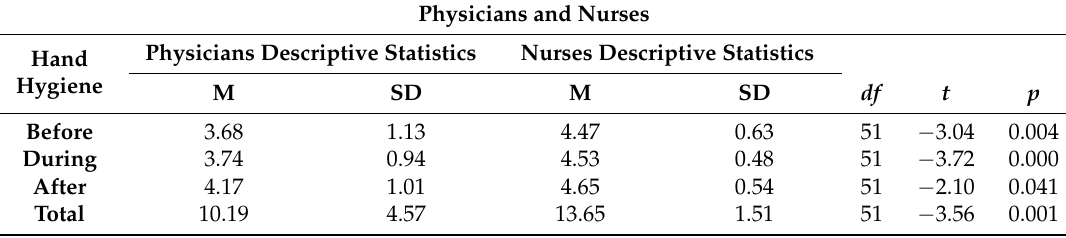
Table 3. Two Independent Sample t -Tests of the Questionnaire Data on Hand-Hygiene Practices.